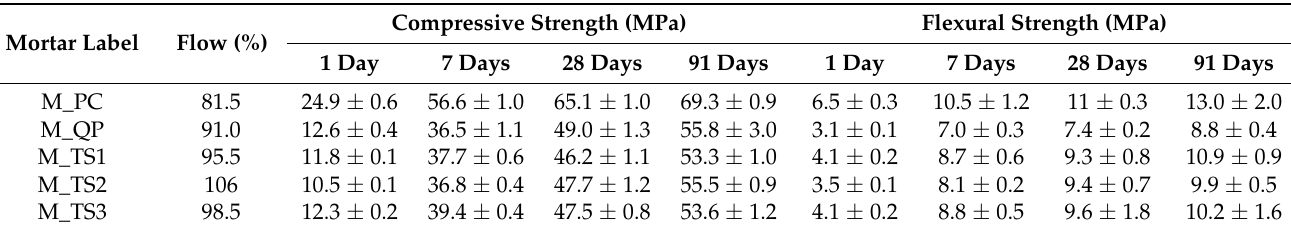
Table 9. The flowability, compressive and flexural strength of the mortar